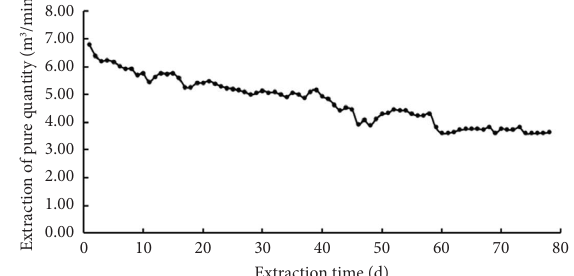
Figure 17: Te net volume change curve of